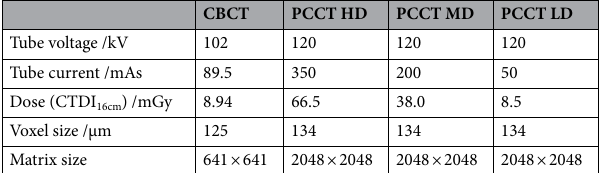
Table 5. Scan protocols used throughout this manuscript. HD high dose, MD medium dose, LD low dose, CTDI computed tomography dose